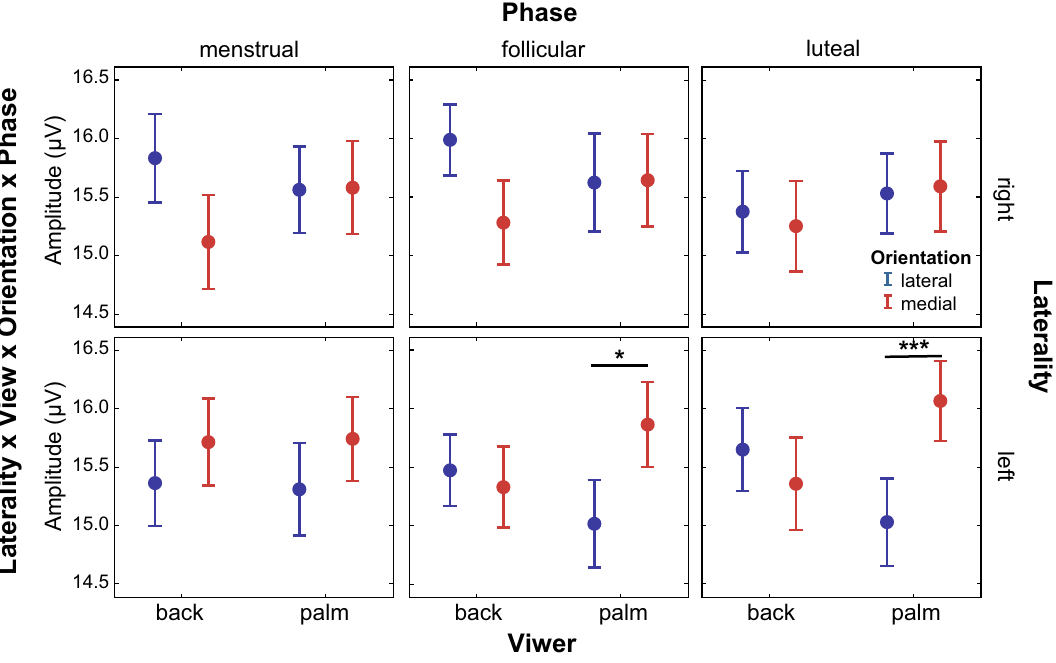
Figure 7. Effects of the interaction between laterality, view, orientation and phase on the P100 amplitude of the left parieto-occipital region. P100 amplitude differs between lateral and medial orientations for the left hands in the palm view during the follicular and luteal phases of the menstrual cycle. P -value: < 0.001 (***), < 0.01 (**), < 0.05 (*); Bonferroni correction for post-hoc